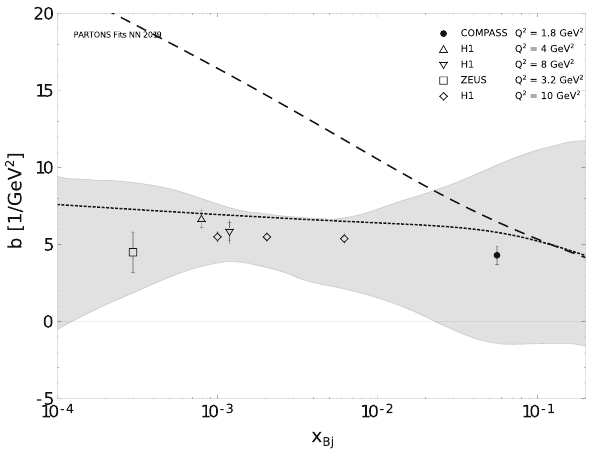
Fig. 22 Comparison between the results of this analysis, the selected GPD models and the experimental data by the COMPASS [36], ZEUS [37] and H1 [38,39] Collaborations for the slope b at Q 2 = 10 GeV 2 . Note that the shown data differ by Q 2 values indicated in the